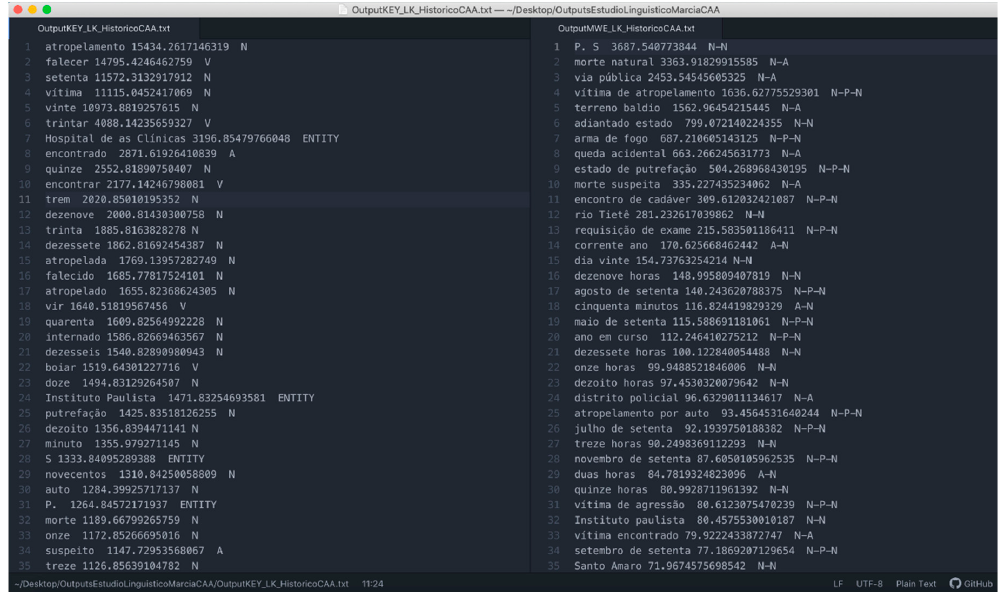
Figure 5. Linguakit output for keywords and multiword analysis of historical information ( Histórico ) in the ‘Disappearances in São Paulo’ corpus.